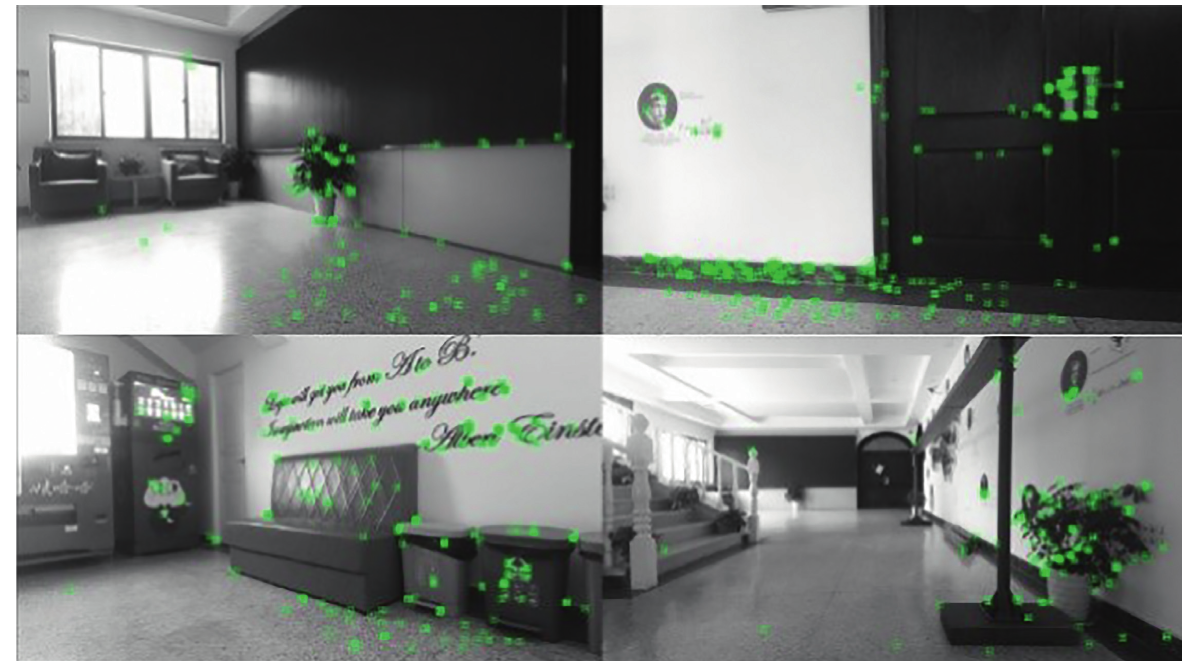
Figure 4: Part of the